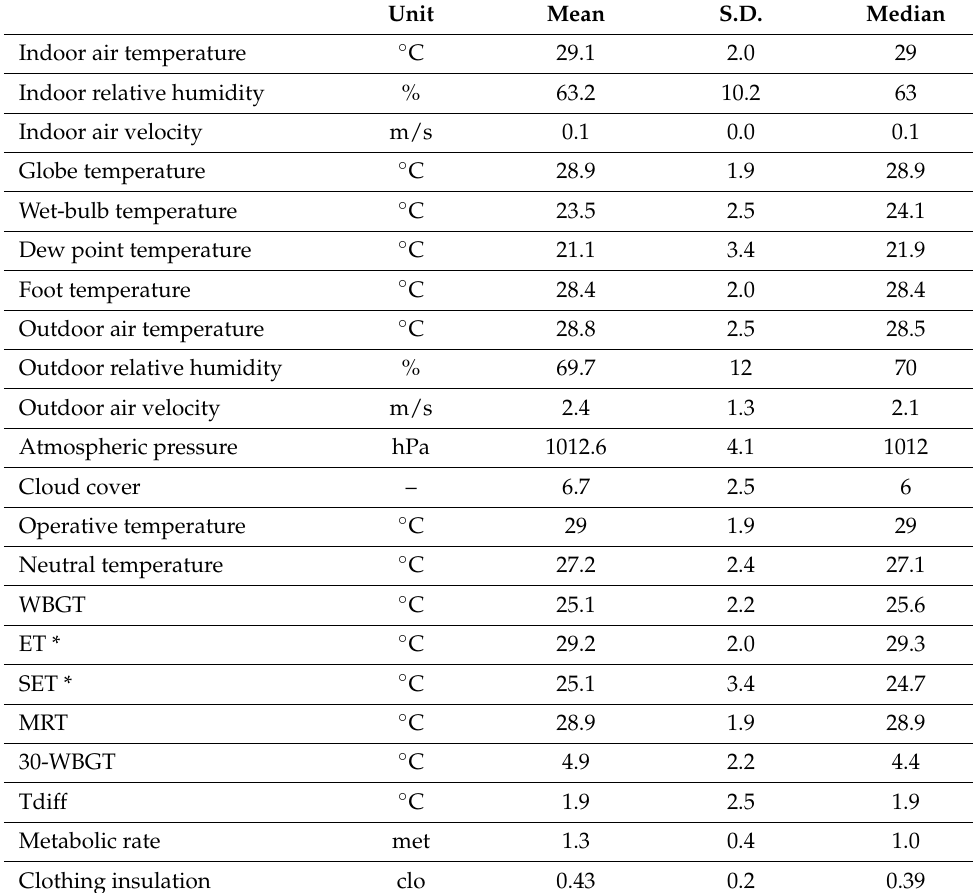
Table 5. Statistical summary of thermal environment data and thermal comfort indices.